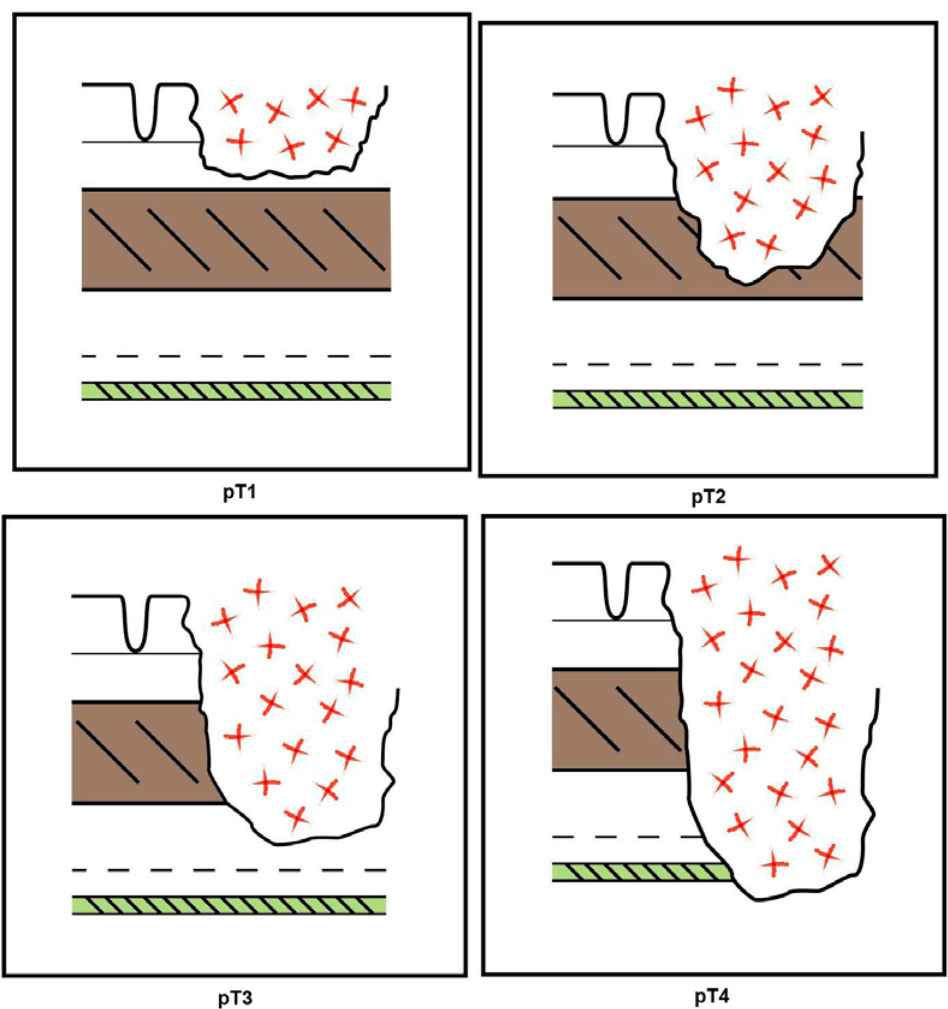
Figure 2. Schematic representation of the pathological substages (pT1 to pT4) of direct tumor